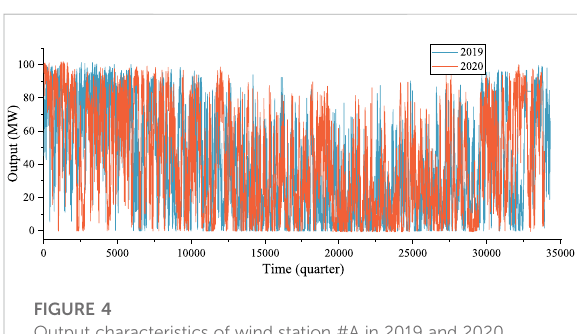
FIGURE 3 Framework of the development potential assessment method of regional clean energy stations.